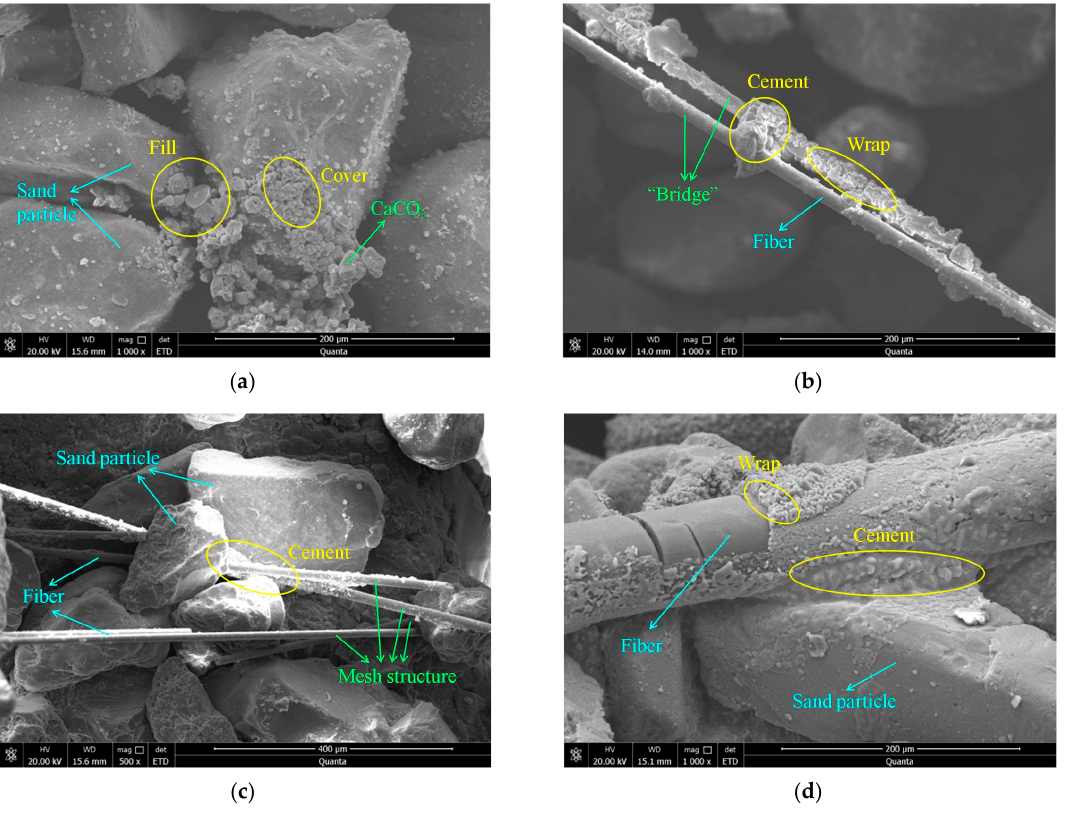
Figure 9. SEM images of solidified aeolian sand ( a ) CaCO 3 distribution; ( b ) bridging effect; ( c ) mesh structure; and ( d ) composite material.